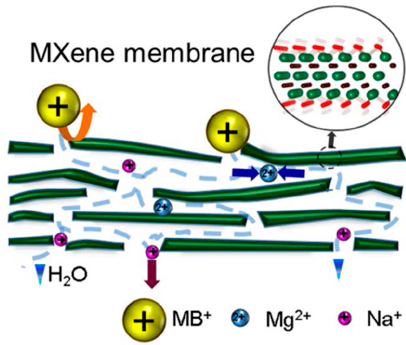
Figure 4. Mechanism of charge- and size-selective ion sieving through MXene membrane. Figure reprinted with permission from Ref. [80]. Copyright American Chemical Society, 2015.